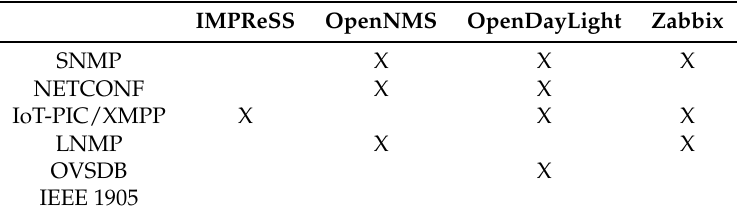
Table 7. Main characteristics comparison of the IoT Network Management